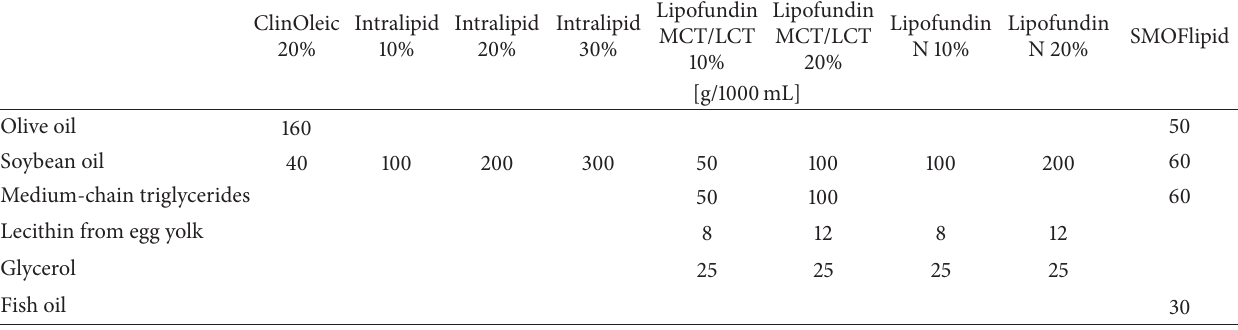
Table 2: Composition of some lipid emulsion